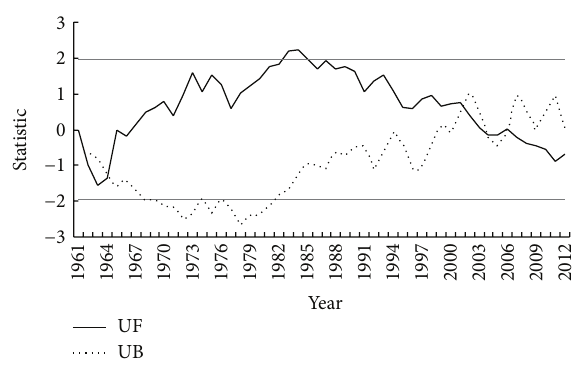
Figure 9: Mann-Kendall testing of abrupt changes of the South China spring precipitation (The 𝑎 = 0.05 significance level is given by the straight